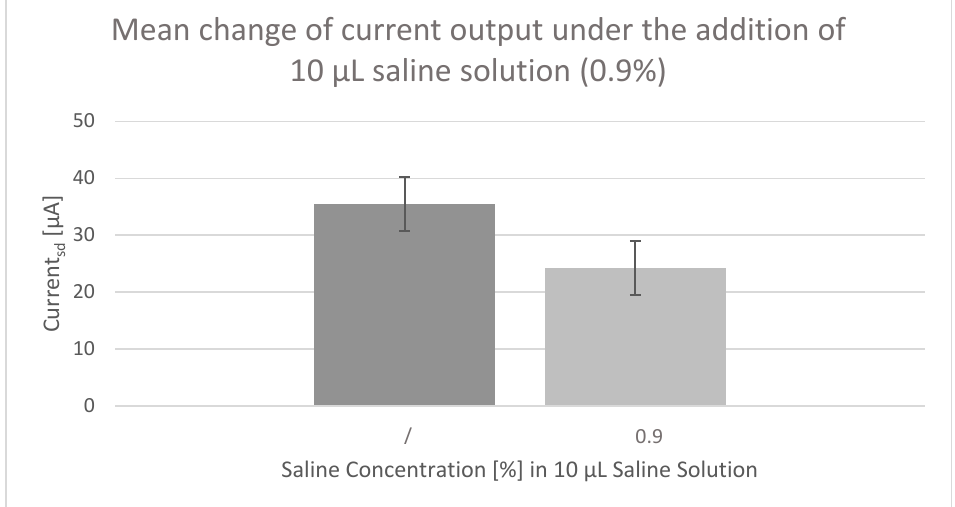
Figure 12. Change in current output under the addition of saline solution over time.